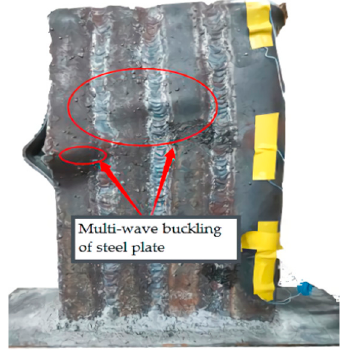
Figure 13. Multi-wave buckling of steel plate.